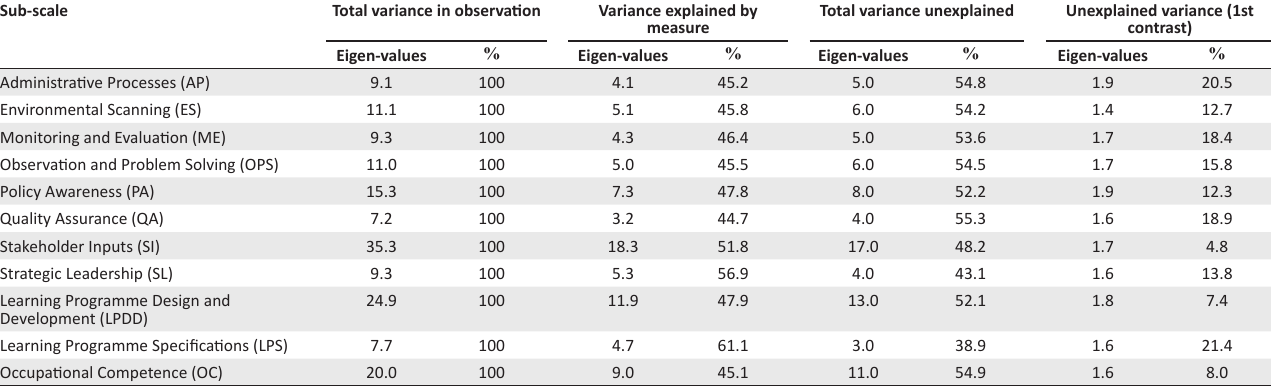
TABLE 3: Summary of the principal component analysis results for the sub-scales of the learning programme management and evaluation scale.